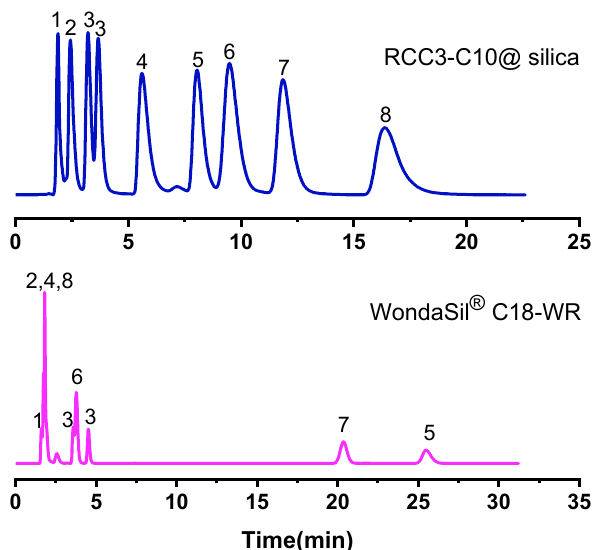
Figure 5. Chromatogram of chiral and achiral compounds on the RCC3-C10@silica molecular cage column and WondaSil ® C18-WR column. Analytes: (1) cytidine, (2) o-phenylenediamine, (3) 1-phenyl-1-propanol, (4) sulfapyridine, (5) tert-butyl benzene, (6) 4-hydroxyflavanone, (7) biphenyl, (8) sulfadimidine. Mobile phase: 70% methanol/water ( v / v ); Flow rate: 1.0 mL/min; UV: 254 nm.